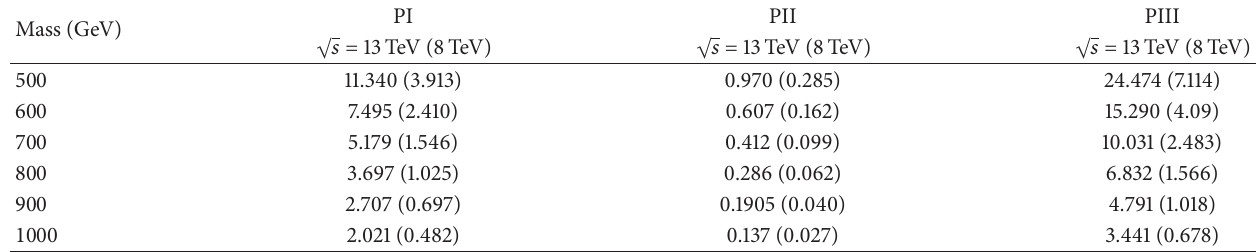
Table 6: The cross sections (in pb) of new heavy quark 𝑏 󸀠 production without cuts for PI, PII, and PIII parametrizations at the center of mass energy of 13 TeV ( 8 TeV), respectively.